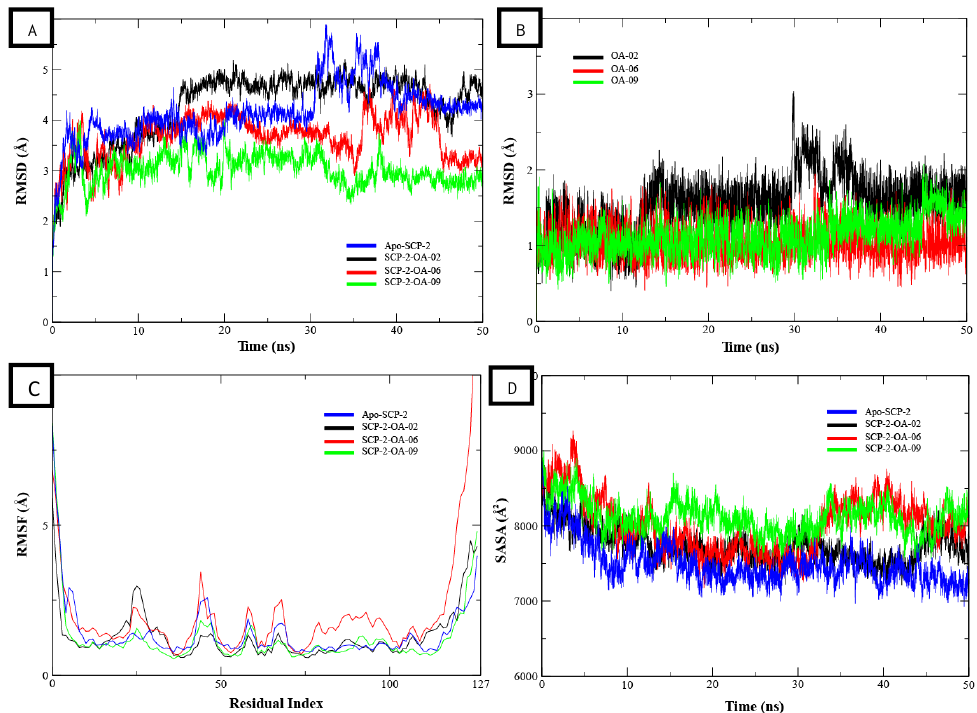
Figure 2. The binding stability analysis of protein – ligand complexes by MD Simulation. ( A ) RMSD plots of backbone of protein (blue) and its complexes OA-02 (black), OA-06 (red) and OA-09 (green). ( B ) The RMSD plots of ligands. ( C ) The residual flexibility analysis of the protein and complexes. ( D ) The solvent exposed area analysis of protein and its complexes.